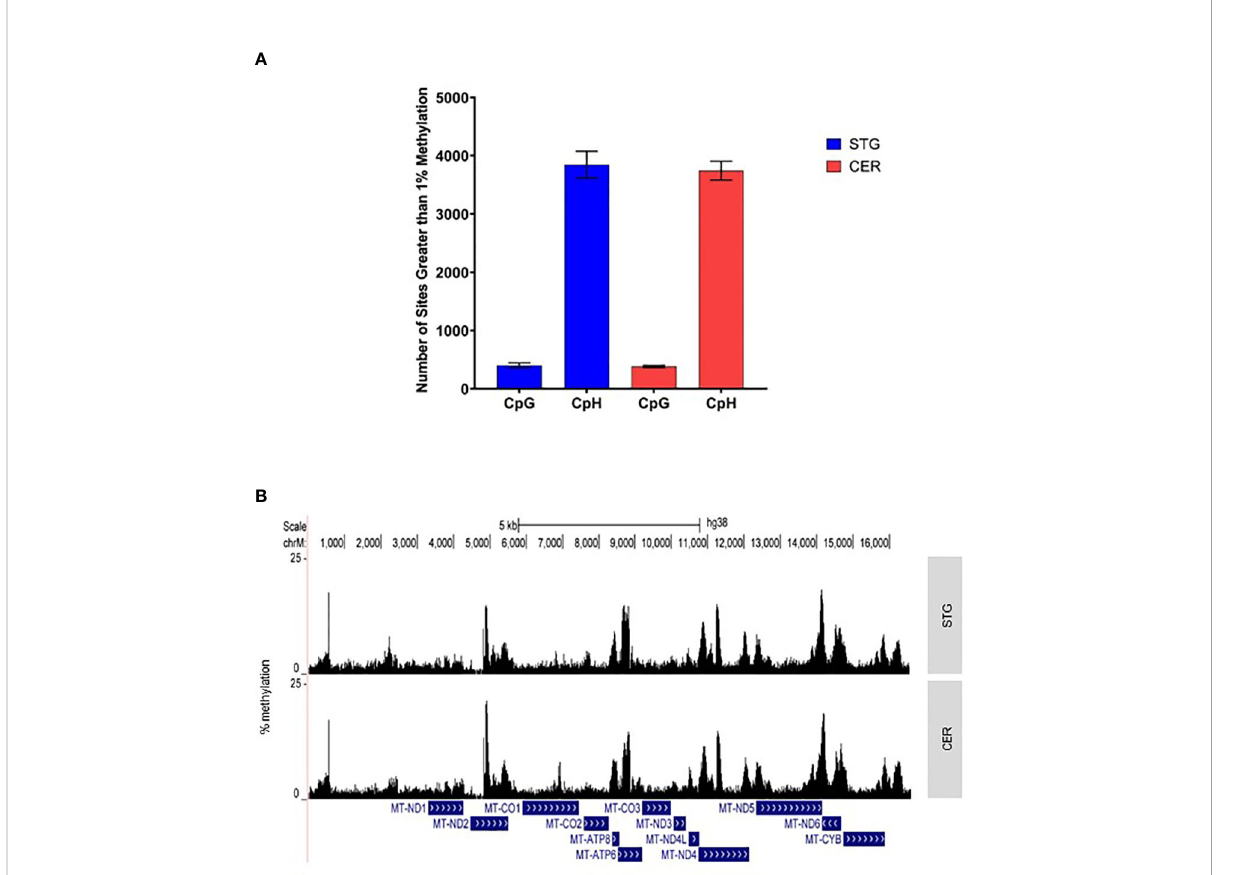
FIGURE 1 The mitochondrial genome is characterized by speci fi c regions of methylation, predominantly in a CpH context. (A) Shown is the mean number of sites with >1% methylation in the STG (blue) and CER (red) in either a CpG or CpH context. Error bars represent the standard error of the mean (SEM). (B) Graph showing mean % methylation at each cytosine in the mitochondrial genome in STG (top panel) and CER (bottom panel) samples, created using UCSC browser